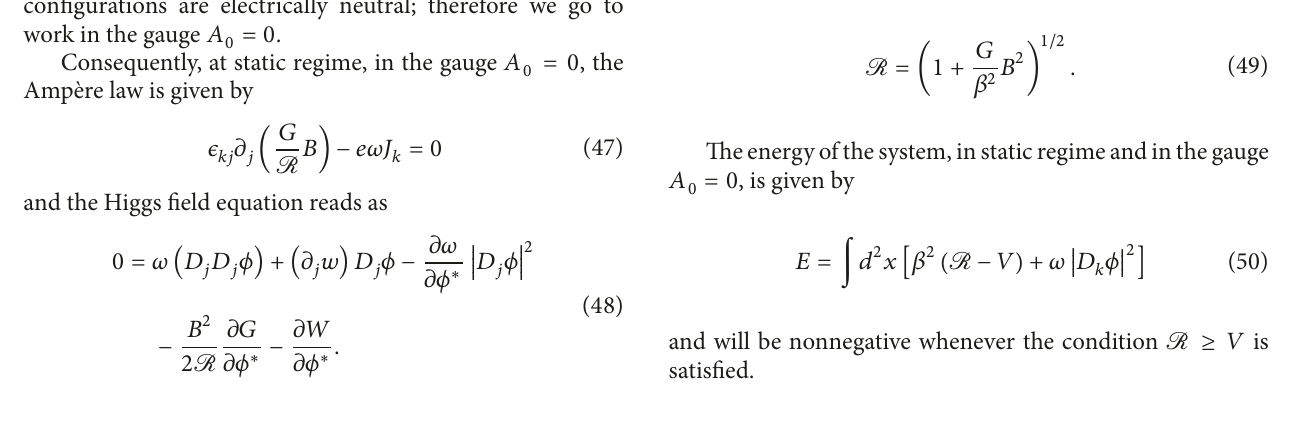
Similarly to what happens in Maxwell-Higgs model, the field configurations are electrically neutral; therefore we go to work in the gauge 𝐴 0 = 0